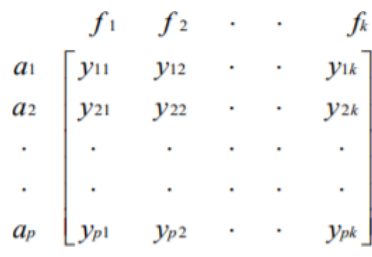
Figure 9: Criterion matrix